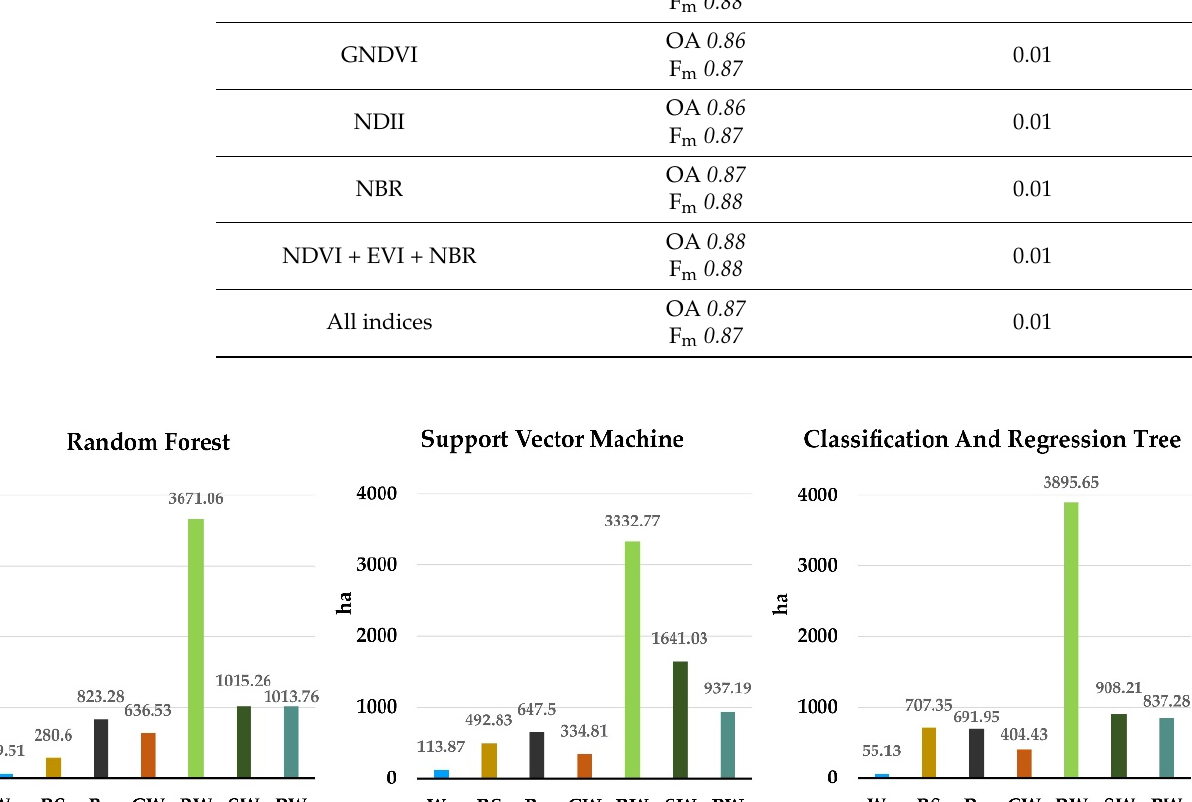
chestnut woodland; BW: beech woodland; SW: silver fir woodland; PW: pine woodland).